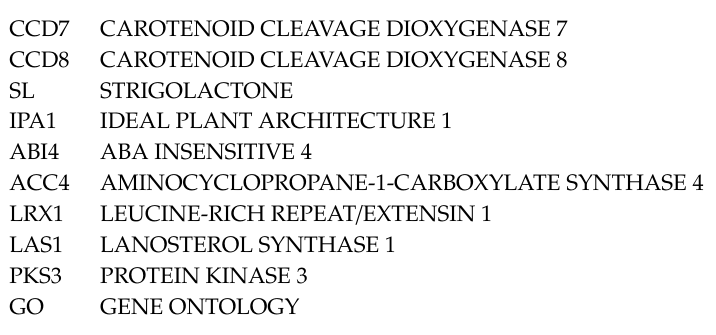
Figure S1: Comparison of signal distribution between biological repeats of samples, Figure S2: Hierarchical clustering of significantly changed genes of expression max mutants compared with wild-type and the log2 ratio used for normalizing the expression di ff erence, Table S1: List of primers used in this study for qRT-PCR analysis, Table S2: The list of the genes that significantly increased or decreased in max mutants compared to wild-type, Table S3: Commonly expresses genes in max3 , max4 , max1 , and max2 , Table S4: Commonly expressed genes in max1 and max2 , Table S5: Commonly expressed genes in max3 and max2 , Table S6: Commonly expressed genes in max3 and max1 , Table S7: Commonly expressed genes in max4 and max1 , Table S8: A list of max3 -specific changed gene, Table S9: A list of max1 -specific changed genes, Table S10: A list of max2 -specific changed